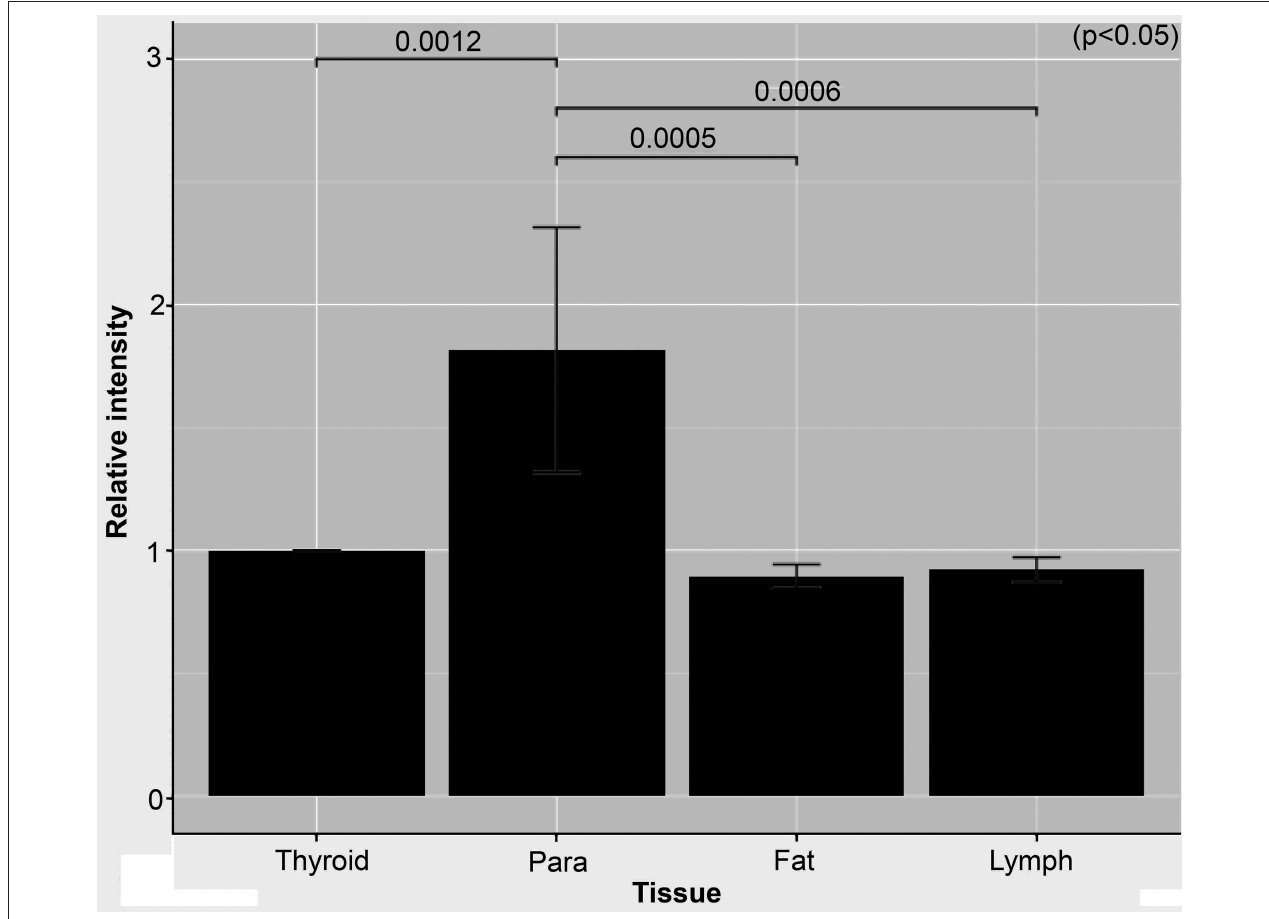
FIGURE 5 | Graph of the relative intensity of each tissue. The average relative intensity for the nine sample sets of the parathyroid (Para), fat, and lymph node (Lymph) compared with the thyroid is shown. As shown parathyroid was almost 2-fold brighter.